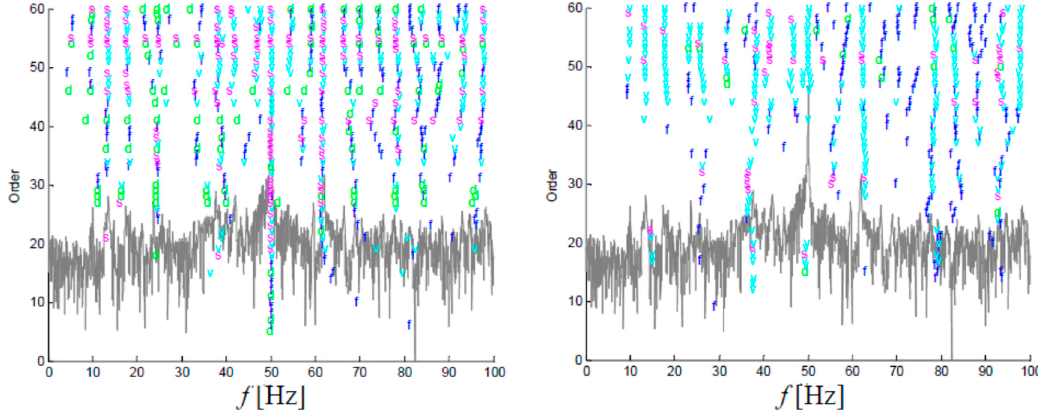
Figure 12. Stabilisation diagrams obtained for the LSCE ( left ) and BR ( right ) algorithms.